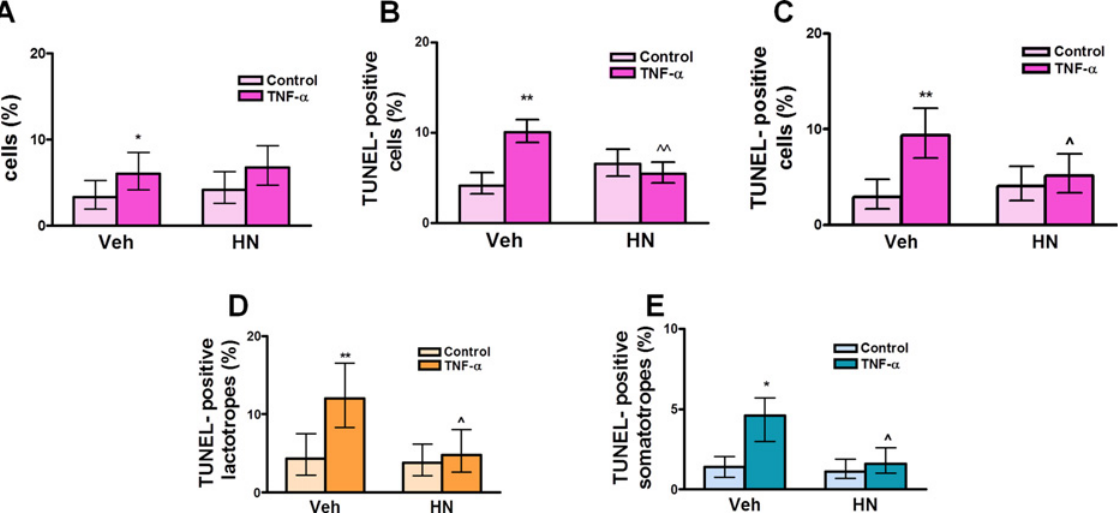
Fig 6. HN protects anterior pituitary cells from TNF- α -induced apoptosis in female rats. Cultured anterior pituitary cells from OVX rats were incubated with 17 β -estradiol (E 2 , 10 -9 M) for 24 h and then with HN 0.25 μ M (A), 0.5 μ M (B), or 1 μ M (C) for 2 h before adding TNF- α (50 ng/ml) for an additional 24 h. Apoptosis was assessed by the TUNEL method. In cells incubated with 0.5 μ M HN, apoptotic lactotropes (D) and somatotropes (E) were identified by immunofluorescence. Each column represents the percentage ± CL of TUNEL-positive anterior pituitary cells (A, B, C, n (cid:1) 1500 cells/group), lactotropes (D, n (cid:1) 1600 cells/group) or somatotropes (E, n (cid:1) 1800 cells/group). Data from at least two separate experiments were analyzed by χ 2 test. * p < 0.05, ** p < 0.01 vs respective control without TNF- α ; ^ p < 0.05, ^^ p < 0.01 vs respective control without